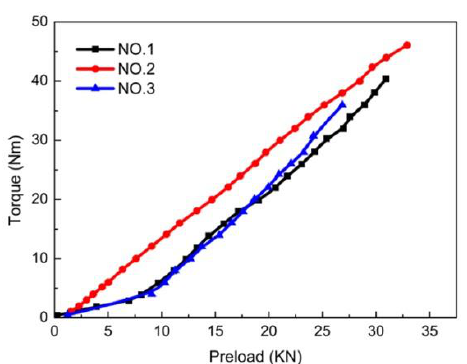
Figure 3. Experimental torque-preload curves of three bolts (M8 × 1, GH4169).